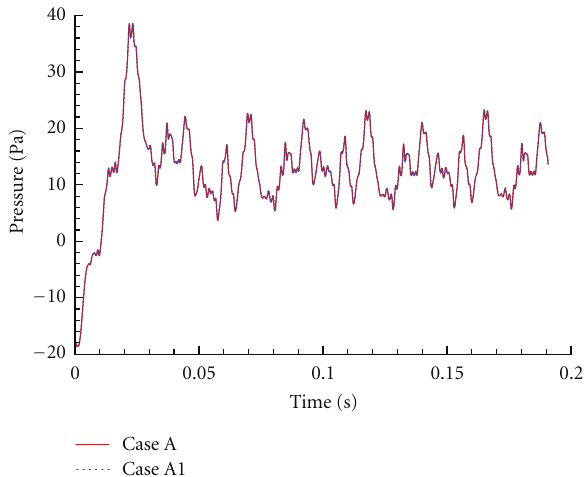
Figure 8: Comparison of time history of pressure oscillation at a monitoring point in the gap between the stabilizer and impeller. Coordinates of monitoring point are ( − 0.04, − 0.0375), while the center of impeller is at (0,0).